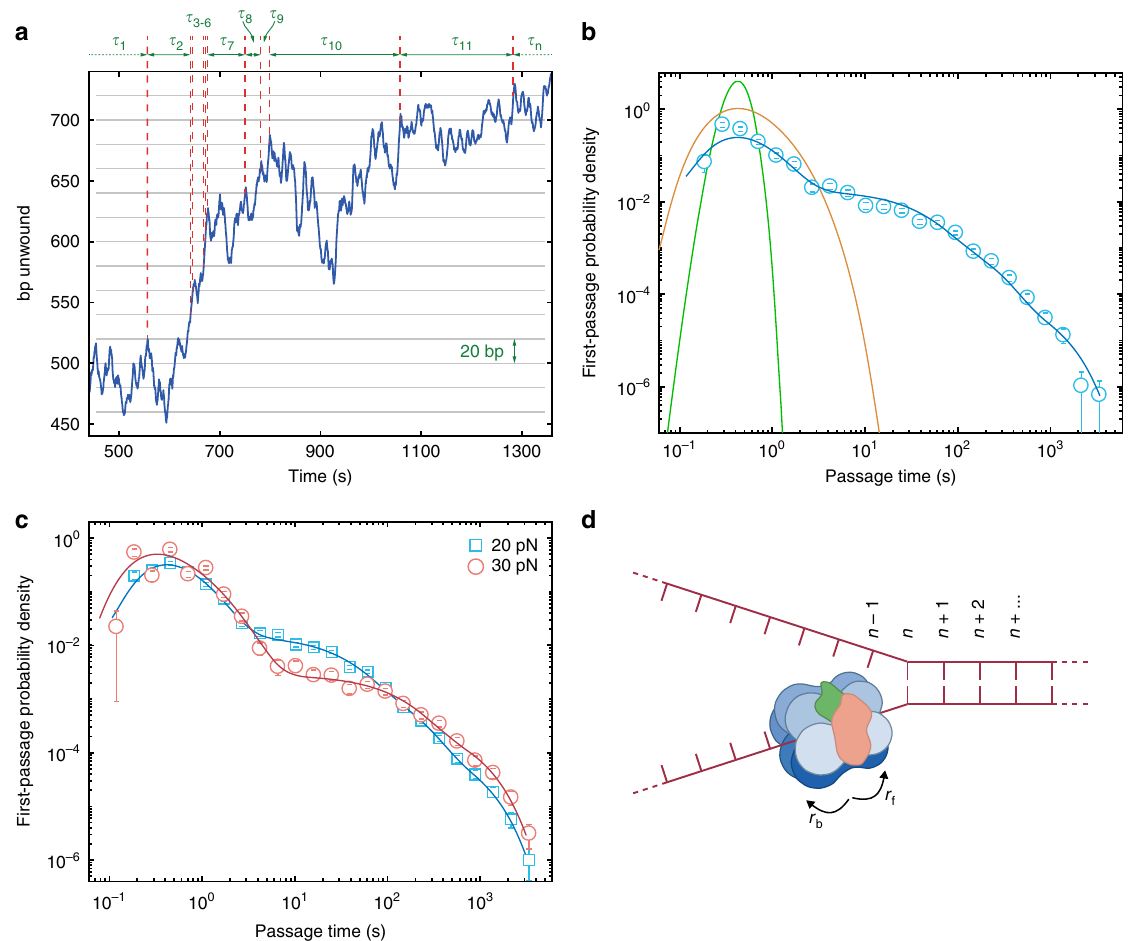
Fig. 3 Extracting dynamic and kinetic information from CMG unwinding trajectories. a Portion of an example unwinding trajectory. Complex motion is observed but assigning any portion to a given state of unwinding, annealing, or pausing, leads to miscounting and is biased. Instead we measure the time taken, τ , for the helicase to fi rst unwind a set interval of basepairs (grey horizontal lines) along the whole trajectory, to give a list of fi rst-passage times. τ 3 – 6 , for example, are short due to the fast unwinding present, τ 10 is long due to re-unwinding of the same DNA and τ 11 is long due to a crudely described pause. b Experimental fi rst-passage time distribution for 4 mM ATP and 20 pN force (blue circles); bins are normalised by bin width and total counts. Blue line is maximum likelihood estimation for the model of Eq 2. Note, the data is not directly fi t to the experimental histogram, MLE estimates the parameters best suited to describe the distribution of all fi rst-passage times. Data from 21 molecules and 1009 fi rst-passage times. Green line is the analytical fi rst-passage time distribution solution for a unidirectional mechanism that includes the stochastic nature of biochemical processes, a gamma function, parameterised by the number of steps to cross the passage interval and the rate of unwinding. A biased random walk provides a broader peak, calculated with the same modal FPT, and is parameterised by the rate of forward and backwards hopping (orange line, fi rst term Eq. 2). c Comparison of two FPT distributions at different forces and constant 4 mM ATP concentration. Blue squares are at 20 pN with a resulting model fi t (blue line) which includes 3 pause states. Red circles are 30 pN with a resulting model fi t (red line) which includes 2 pause states. Data is as reported in Supplementary Table 1. d The helicase is treated as translocating along ssDNA at the ss-dsDNA fork junction by hopping discretely in space, but continuously in time, forward or backwards one base pair at a time with rates r f and r b respectively. All error bars are standard deviation from 1000